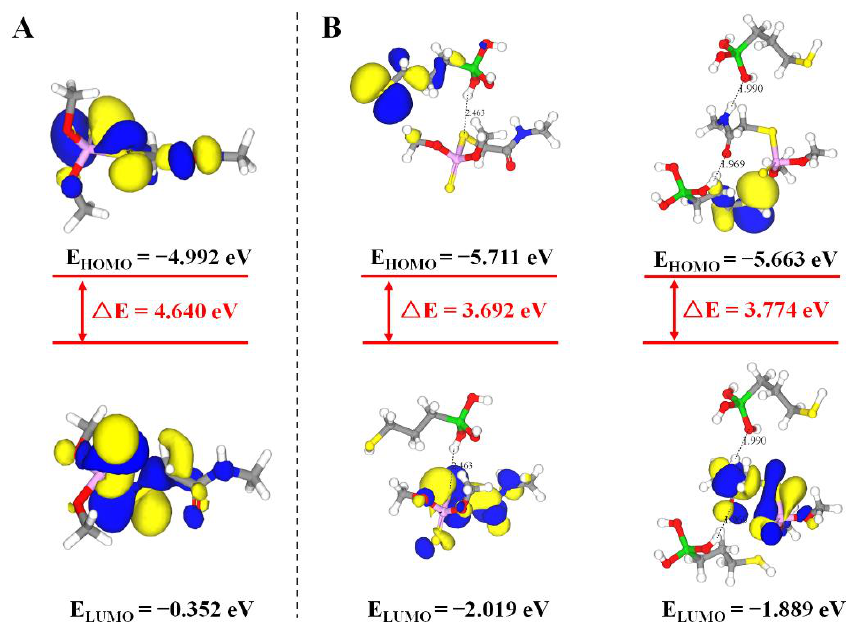
Figure 5. HOMO–LUMO energy gaps and interfacial plots of the orbitals for dimethoate ( A ) and dimethoate–MPTMS ( B ).